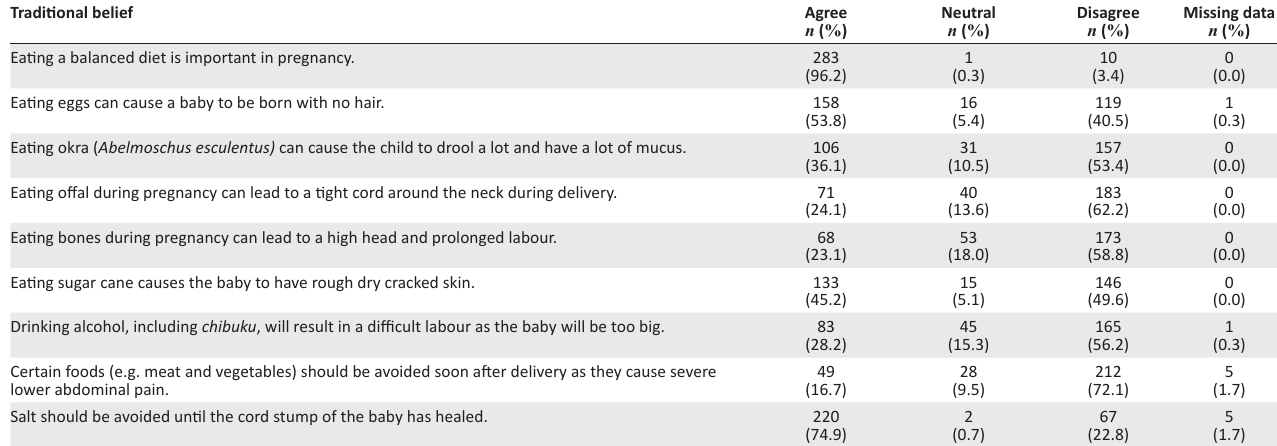
TABLE 3: Traditional beliefs on behaviour during pregnancy questions ( n = 294). Traditional belief Agree Antenatal care should be started as soon as a woman knows she is